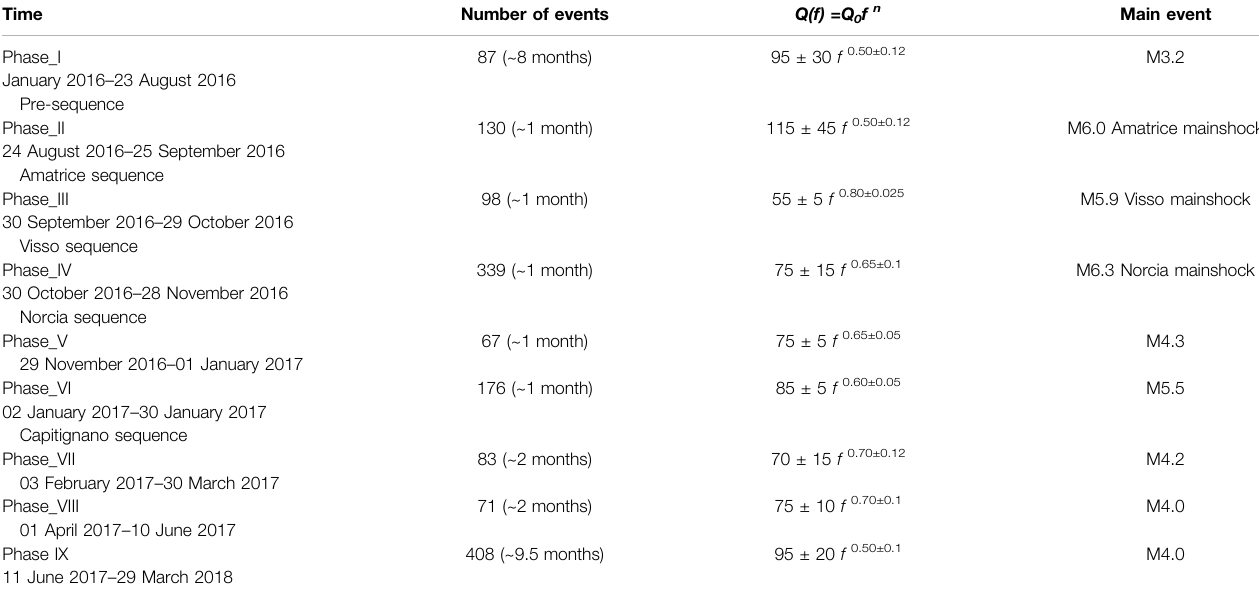
TABLE 1 | S-wave attenuation values obtained in this study as a function of selected time phases and related